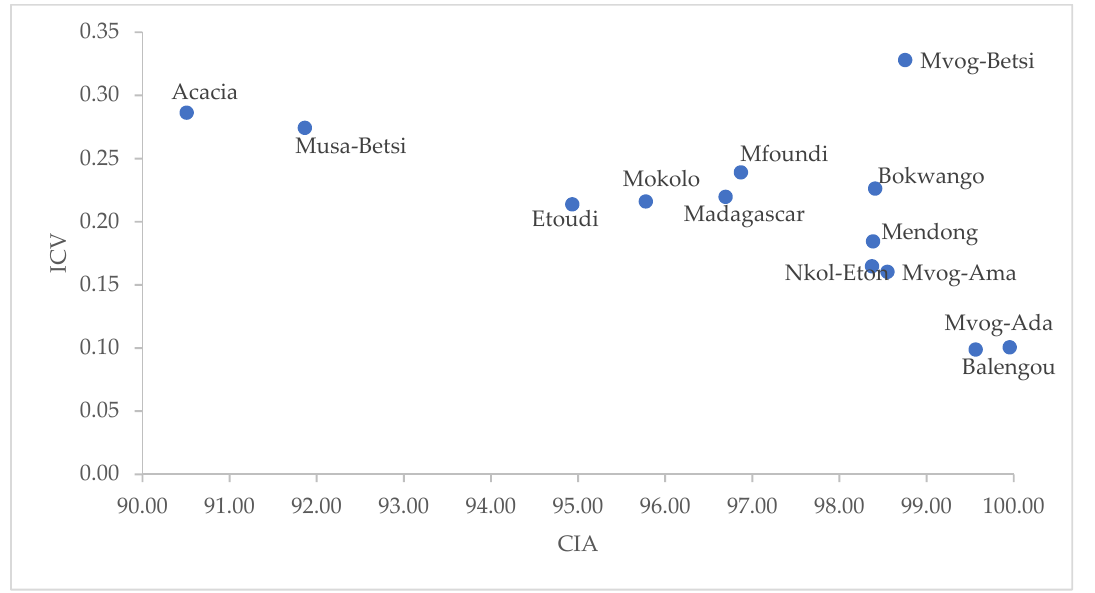
Figure 7. Plot of ICV versus CIA.